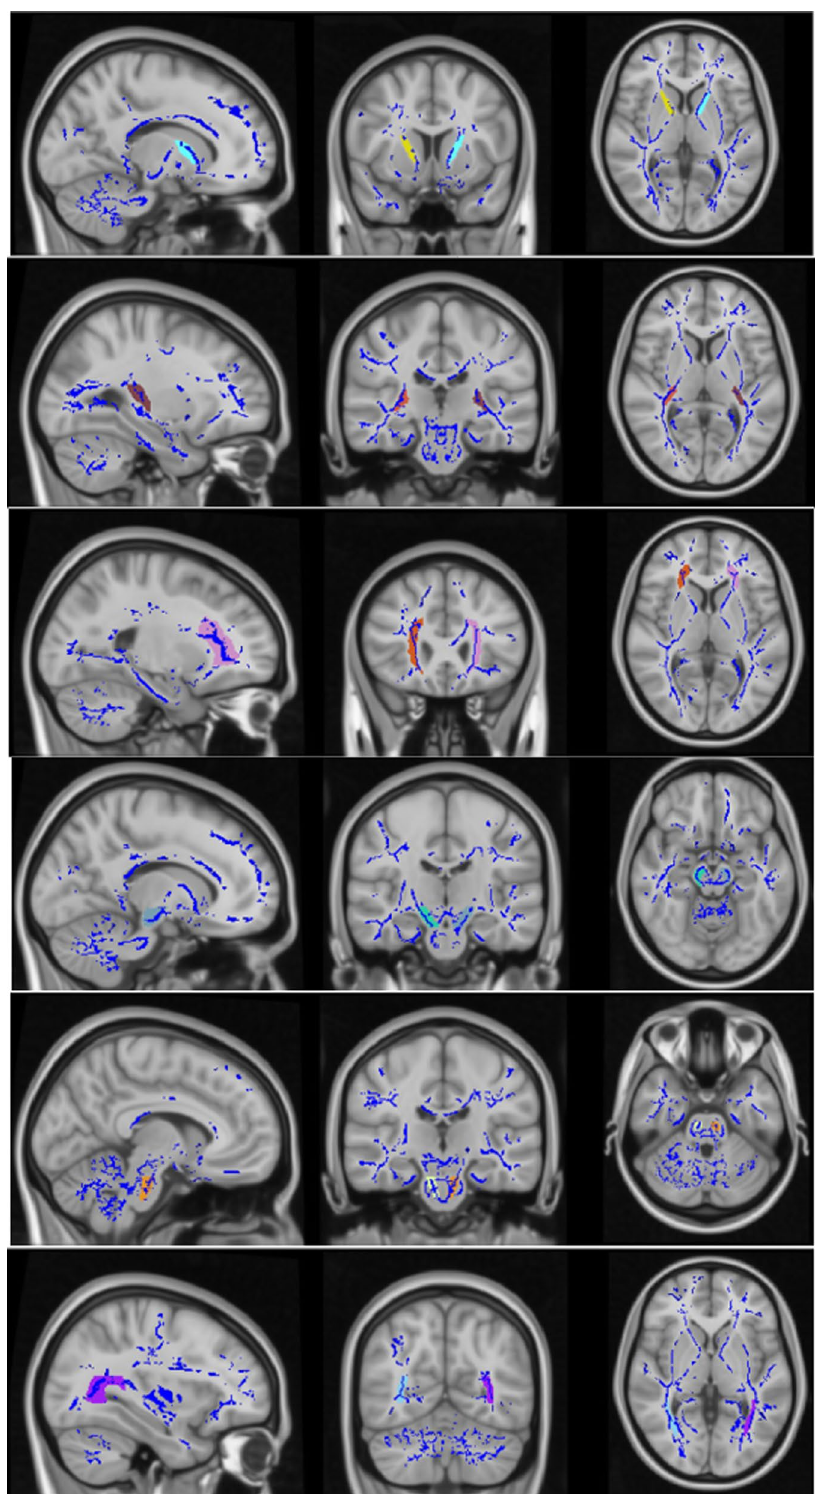
Fig. 10 Projection fibers; anterior limb of internal capsule, retro‑lenticular part of internal capsule, superior corona radiata, cerebral peduncles, cortico‑spinal tracts and posterior thalamic radiation from top to bottom row, respectively, showing statistically significant ( p value < 0.001) higher mean FA value in ASD group compared to TDC group displayed in